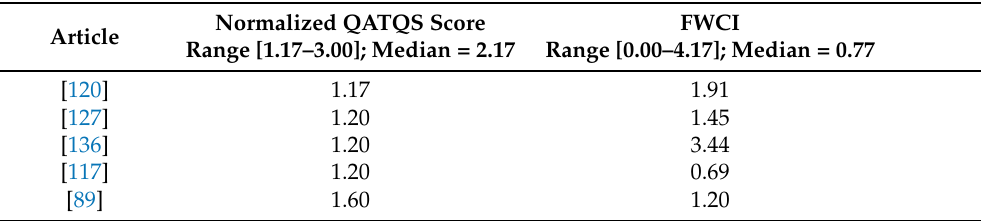
Table 4. The five top scored articles according to the normalized QATQS Score. For each article, the field-weighted citation impact metric by Scopus is also reported (the higher, the best). The normalized QATQS score is computed as the ratio between the global quality score of the article and the number of quality components considered (the lower, the better). FWCI: field-weighted citation